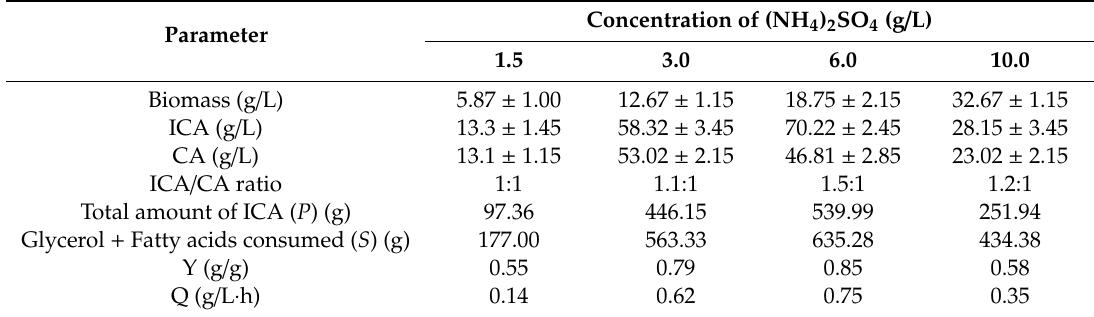
Table 2. E ff ect of nitrogen concentration on the growth of Y. lipolytica VKM Y-2373 and ICA production.